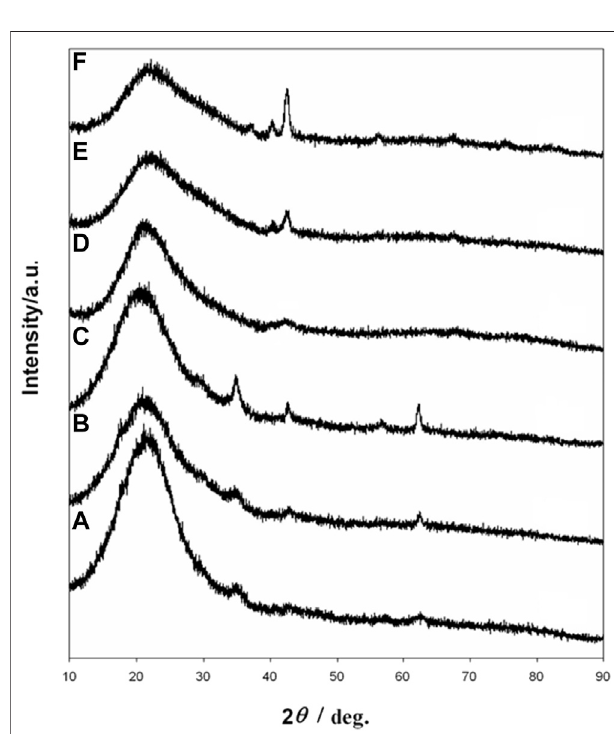
FIGURE 4 | XRD patterns of iron oxide at silica core/shell nanoparticles with (A) 6.1 nm (B) 16.2 nm, and (C) 21.8 nm core (D) iron nitride at silica core/shell nanoparticle transferred from (A) (E) nanoparticles transferred from (B) (F) nanoparticles transferred from (C) .